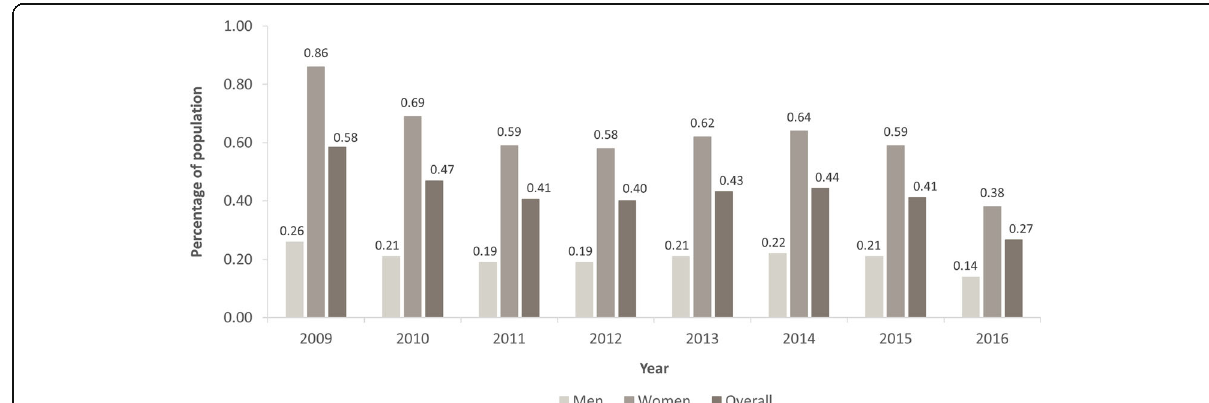
Fig. 5 Extrapolated administrative incidence of migraine over time by sex in the total German Statutory Health Insurance system population. Incidence data could not be calculated for 2008 because the first migraine diagnosis needed to appear at least 1 year after enrolment to be considered incident. Overall incidence values are weighted means, adjusted for sex; 95% confidence intervals are not displayed due to their narrow